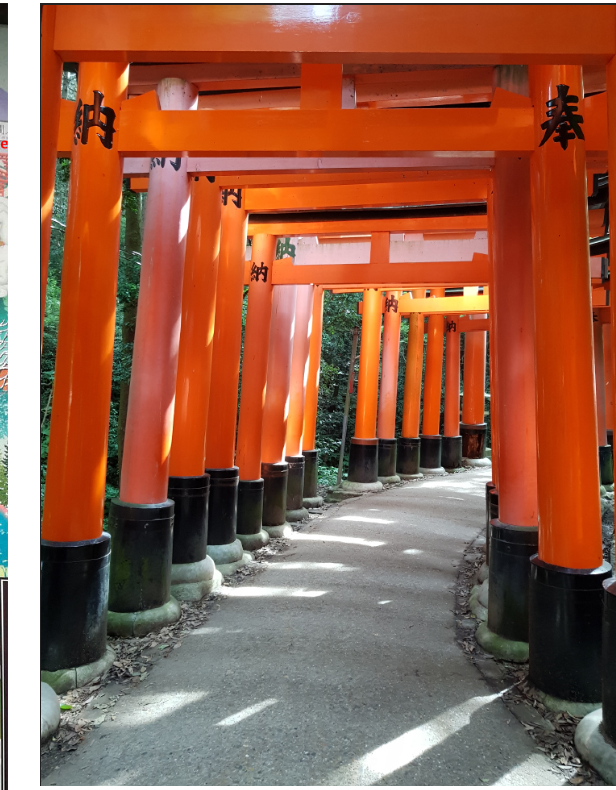
Figure 2: A section of the torii gates along the path towards the